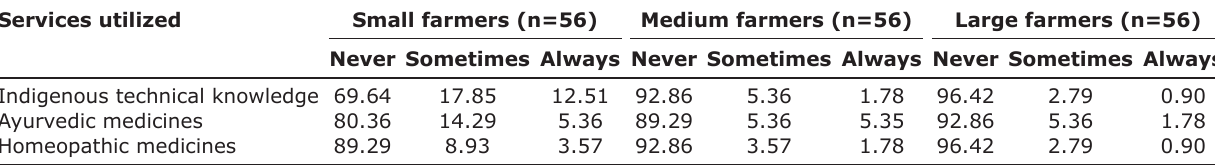
Table-3: Distribution of respondents as per alternatives for allopathic medicines as perceived by them (n=168). Services utilized